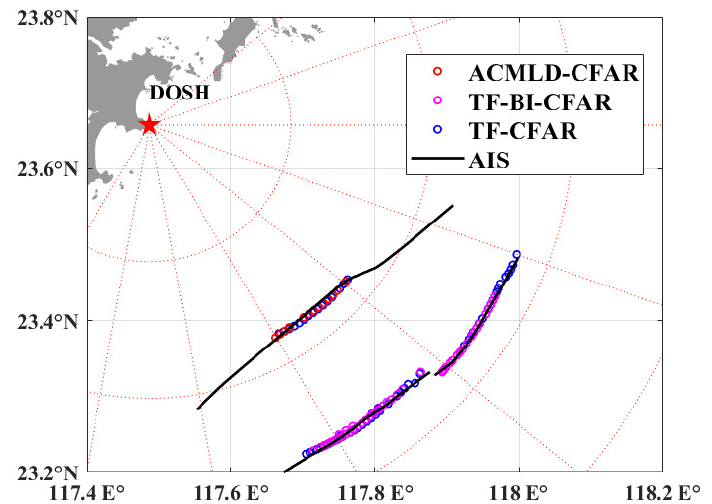
Figure 14. The track of matched targets by ACMLD-CFAR, TF-BI-CFAR, and TF-CFAR.